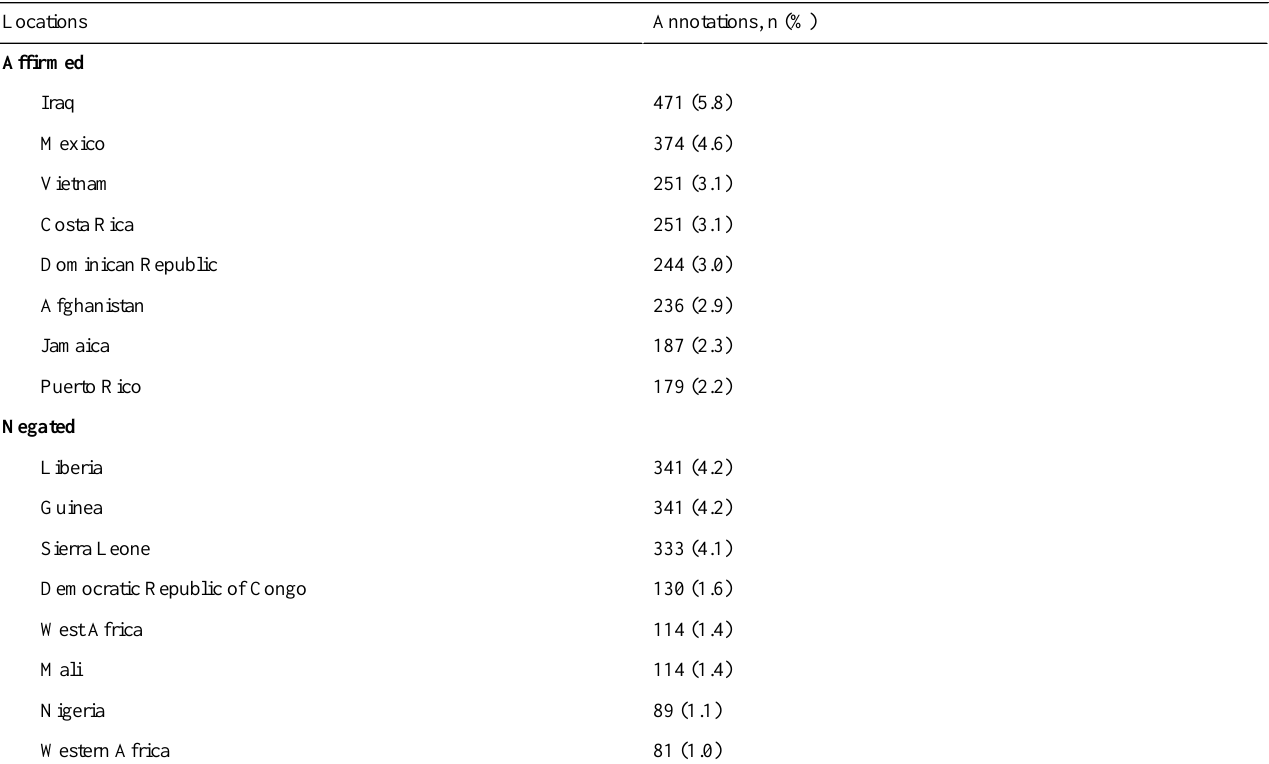
Annotations, n (%)Locations